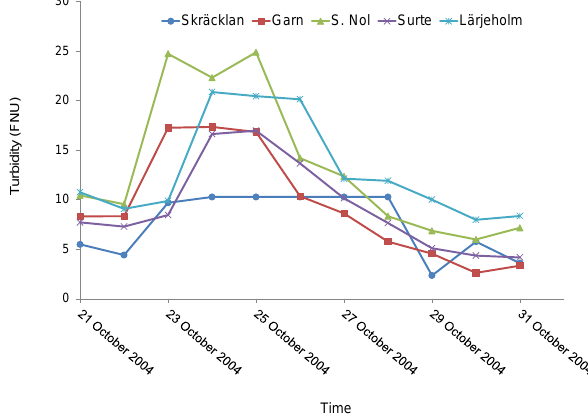
Fig. 9. Turbidity readings at five gauging stations, 21–31 Octo- ber 2004. The figure illustrates the temporal variation in turbidity along the